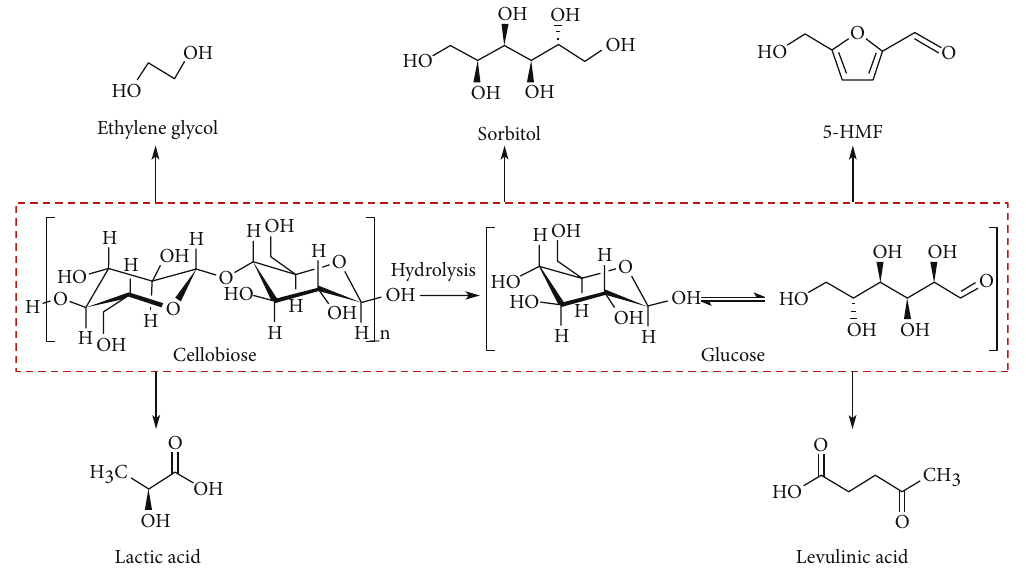
Scheme 2: Direct catalytic conversion of cellulose into key platform